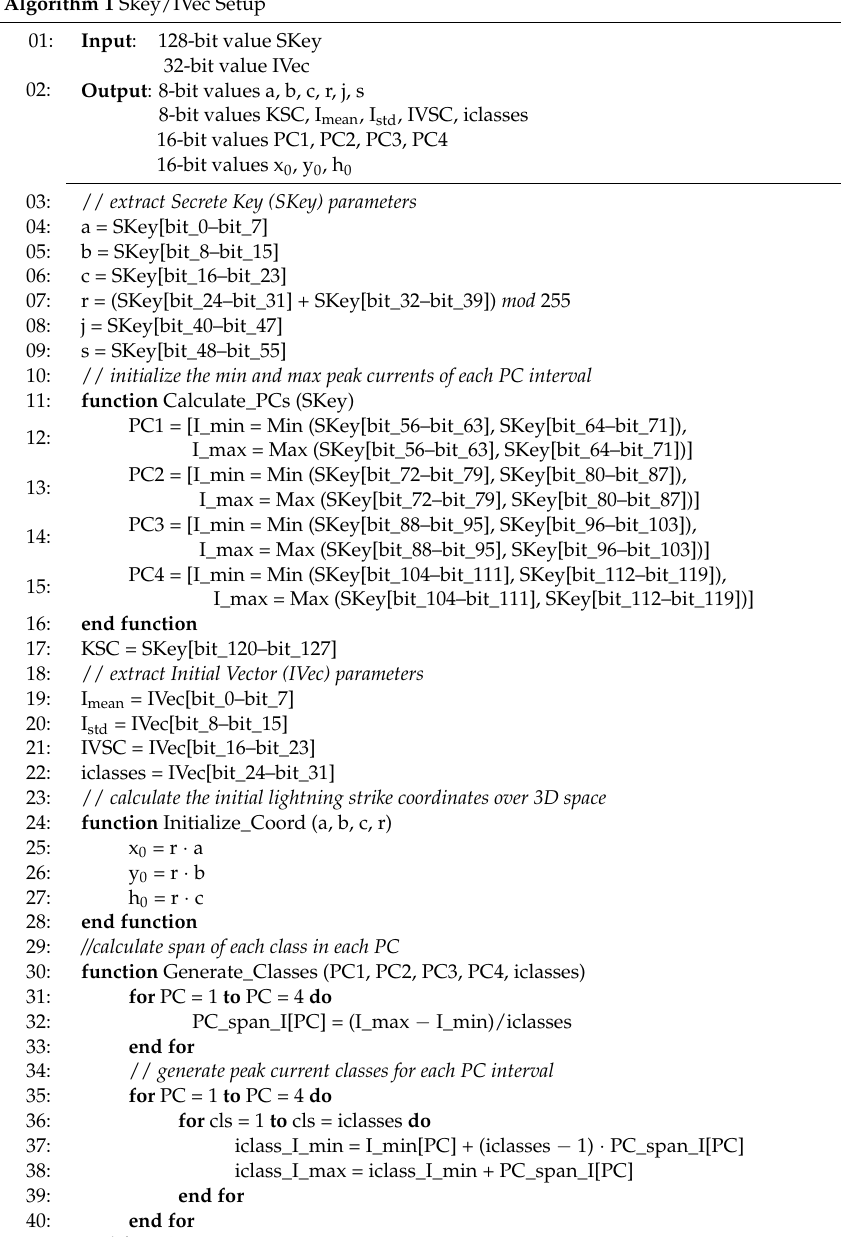
Algorithm 1 Skey/IVec